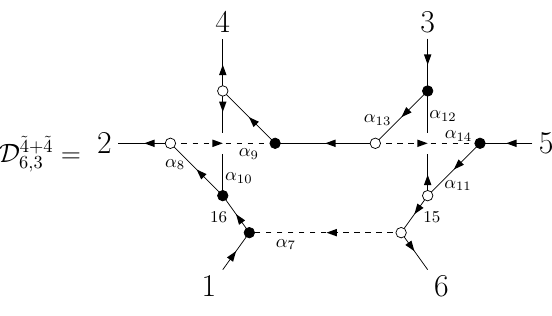
Figure 19 . ‘ ˜4 + ˜4 ’ on-shell diagram with edge variables